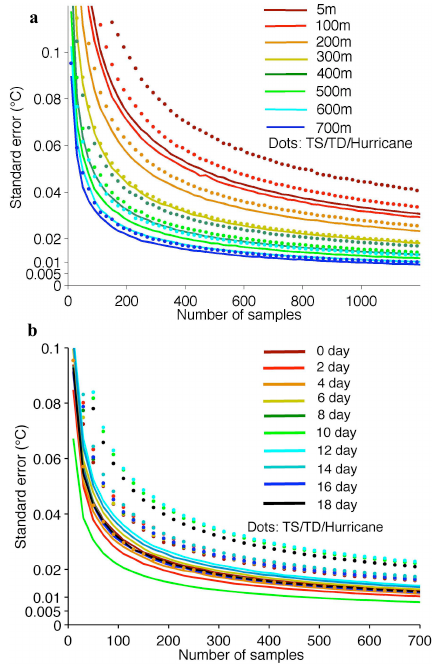
Figure B2. Background ocean temperature variability as a function of depth and time. (a) Mean (green curve) and 1 SD (green shading) of background variability as a function of depth, compared with 1 SD of hurricane and TS/TD affected pairs. (b) Time evolution of background variability of 0–1000m average (light green line and light green shading for mean and SD, respectively). The SDs of temperature anomalies in Argo pairs under TS/TD and hurricane conditions are plotted in light blue and light red, respectively.